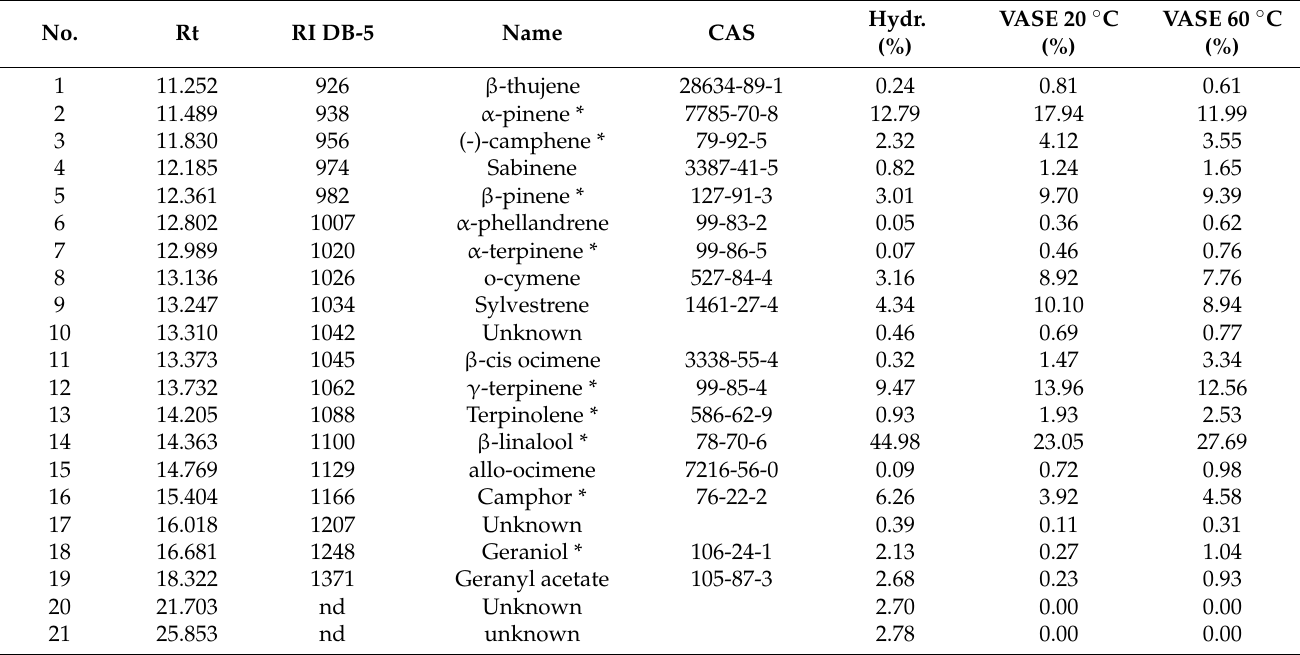
Table 1. Essential oil constituents identified in cold-pressed coriander